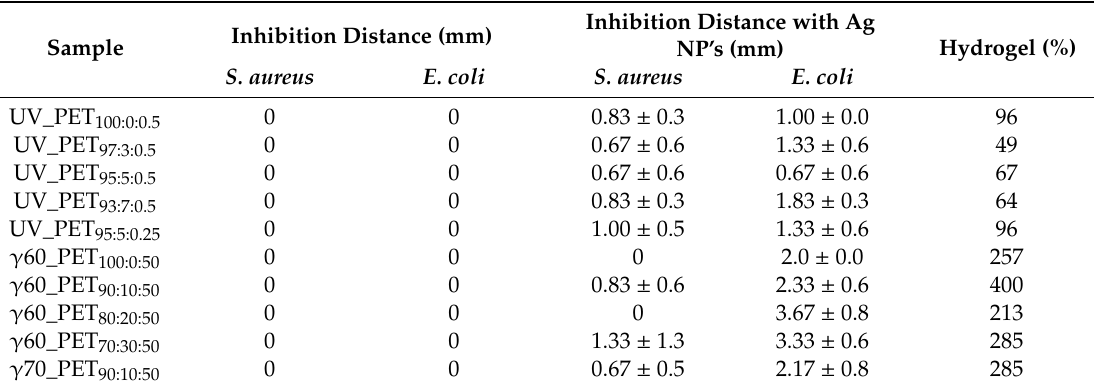
Table 5. Antibacterial results of modified PET